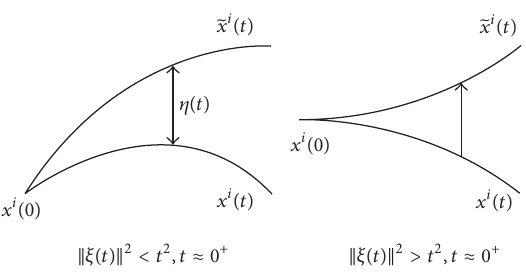
Figure 1: Behavior of the trajectories near